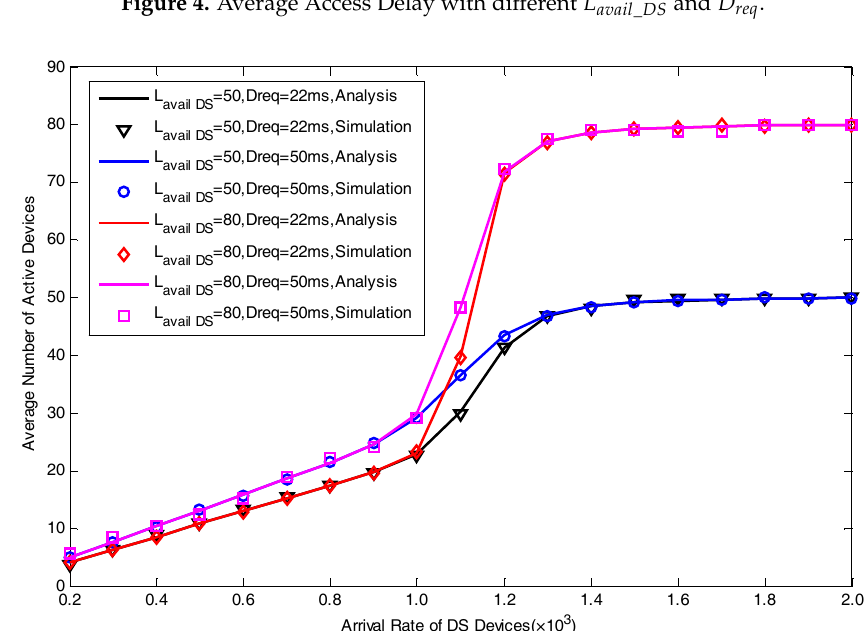
L D and req . Figure 5. Average Number of Active Devices with different L avail _ DS and D req